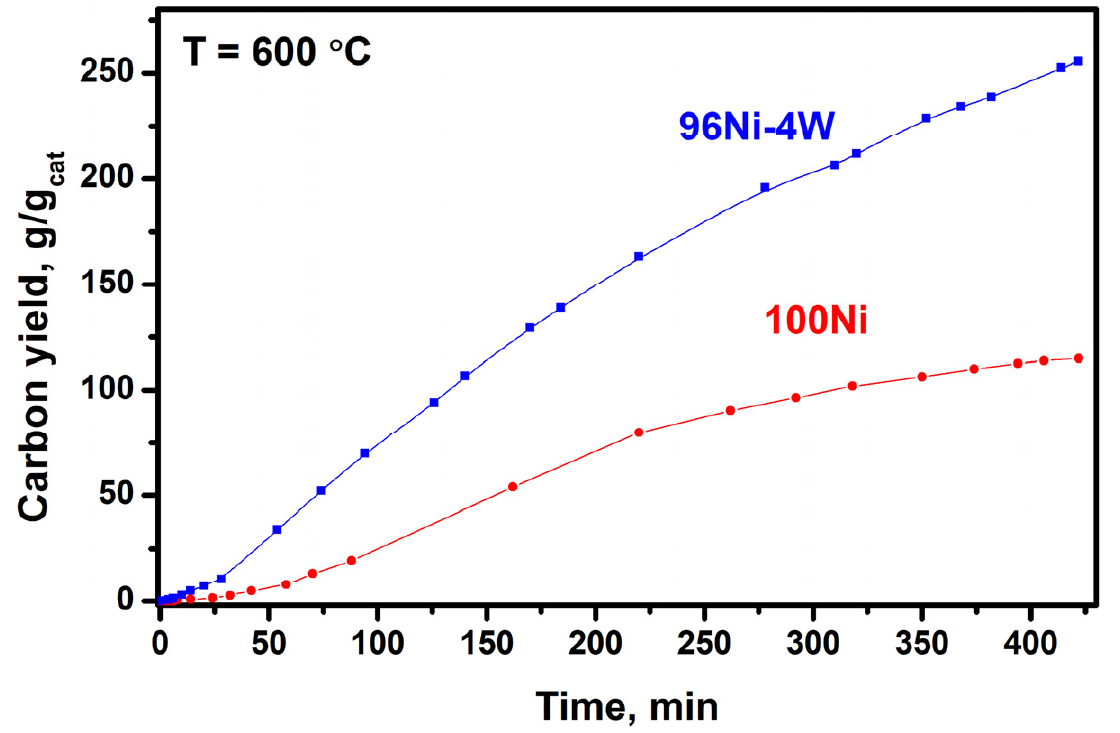
Figure 15. Accumulation of the carbon product during the decomposition of TCE over 100Ni and 96Ni-4W catalysts for 7 h at 600 °C. Table 3. Parameters of the TCE decomposition reaction carried out over 100Ni and 96Ni-4W cata- lysts for 7 h at 600 °C.